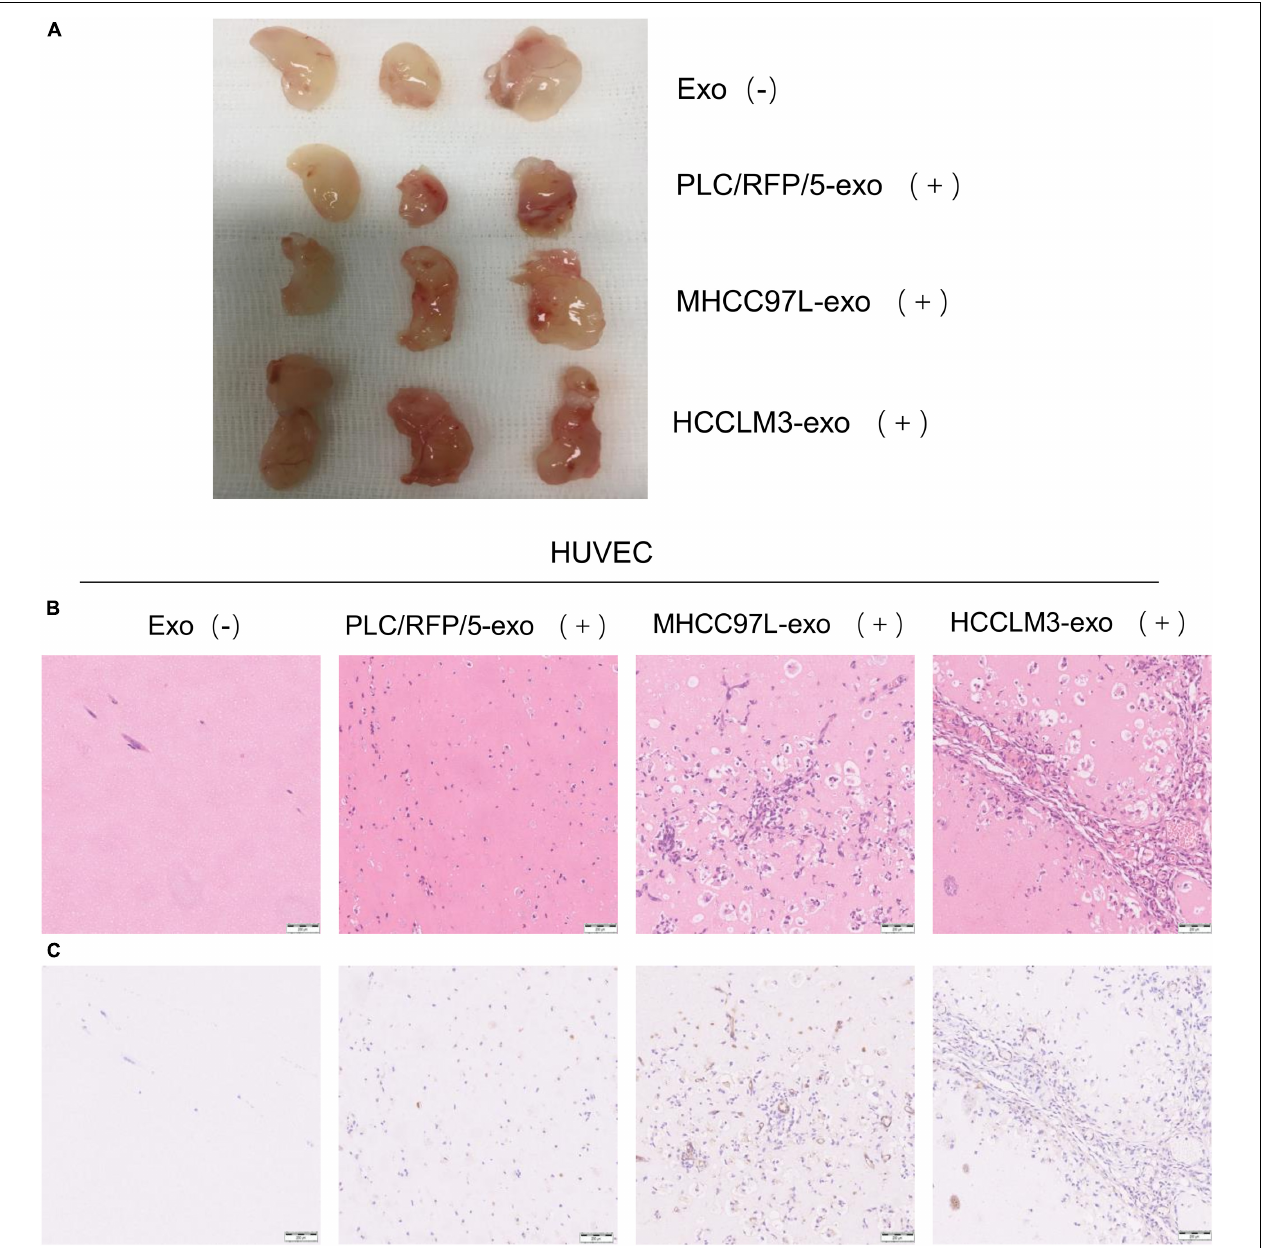
FIGURE 3 | HCC derived exosomes promote angiogenesis in vivo . (A) Matrigel plug assay performed by subcutaneous injection of Matrigel mixed with/without HCC exosomes (100 µ g) in 12 BALB/c nude mice ( n = 3/group). (B) Representative of H&E staining of matrigel plug: PBS; PLC/RFP/5 EXOs; MHCC97L EXOs; and HCCLM3 EXOs. ( × 100), scale bar, 200 µ m. (C) Matrigel plug were formalin-fixed, paraffin-embedded, sliced and stained with CD31 and representative images of each group were